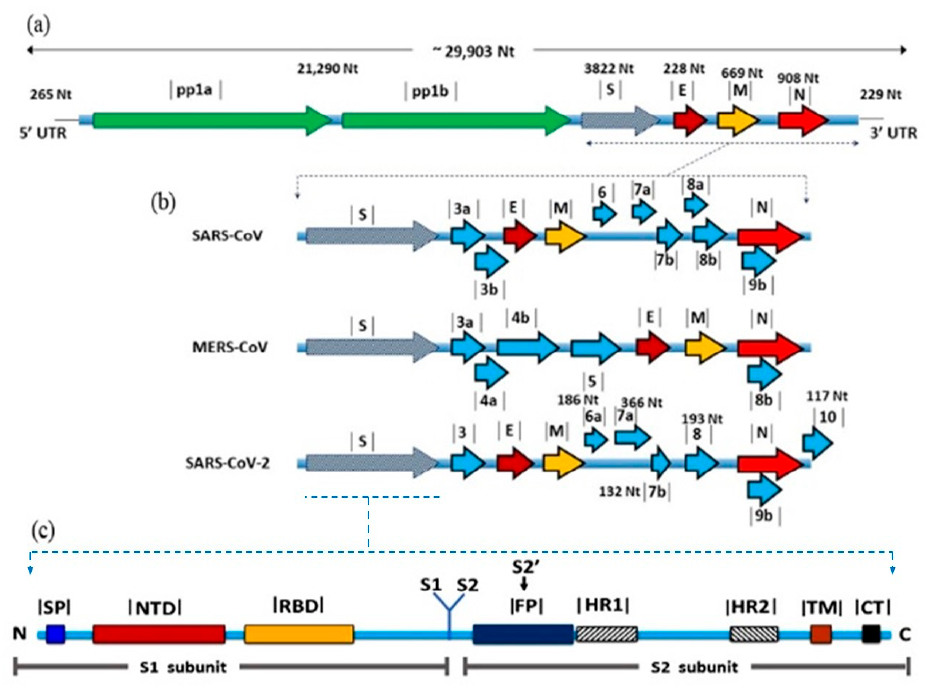
Figure 1. Genomic organization and gene view of three human betacoronaviruses. (a) Coronavirus genome is a positive sense ssRNA, which is flanked by two untranslated regions, 5’ UTR and 3’ UTR. The first two thirds of the genome, ORF1a/b encoding for non-structural proteins required for virus replication. Structural proteins including E, M and N nucleoprotein, and accessory proteins, ( b ) comparison between the three CoVs in terms of the number and positions of accessory proteins, ( c ) detailed structure of the S protein showing the domains involved in receptor binding S1 and membrane fusion S2.